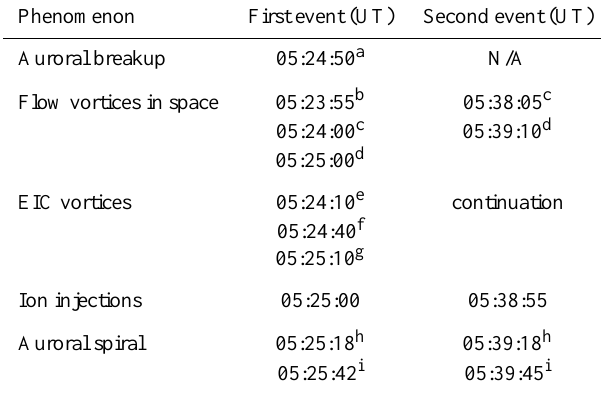
Table 1. Summary of various onset times (approximate): the auro- ral breakup, the auroral spirals as recorded in the ASI data, the EIC vortices as determined from ground magnetometer data, and the vortical plasma flows in space as recorded by the THEMIS space-